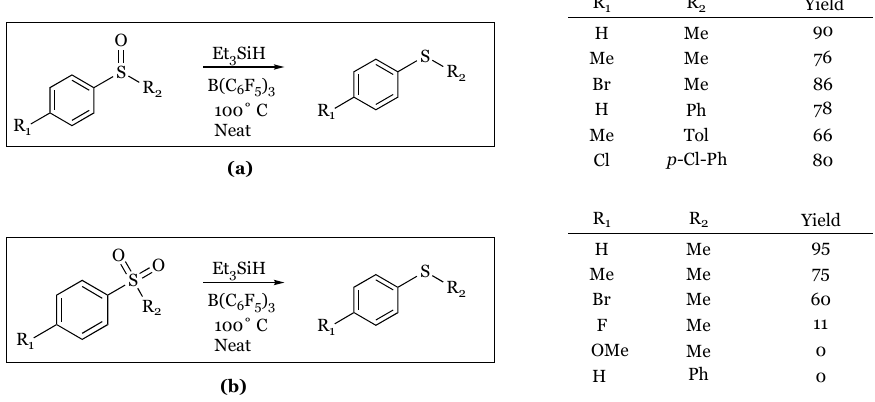
Figure 9. Reduction of ( a ) sulfoxides and ( b ) sulfones to sulfides.